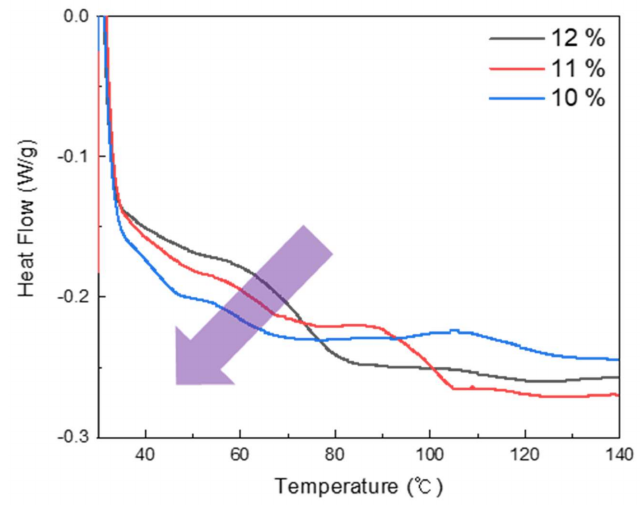
Figure 5. Results of DSC data for three ratios of hardener to epoxy resin.